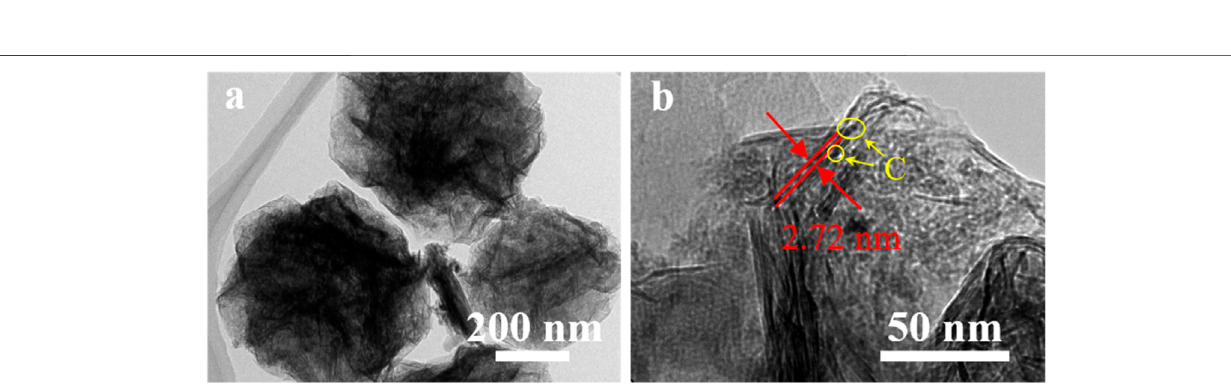
Frontiers in Chemistry |